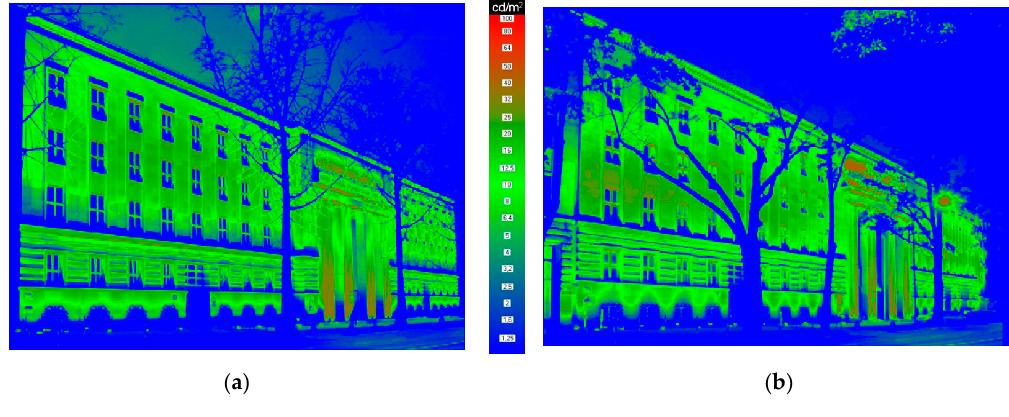
Figure 7. Comparison of luminance measurements of VR display for: ( a ) rendering and ( b ) post-implementation photograph.